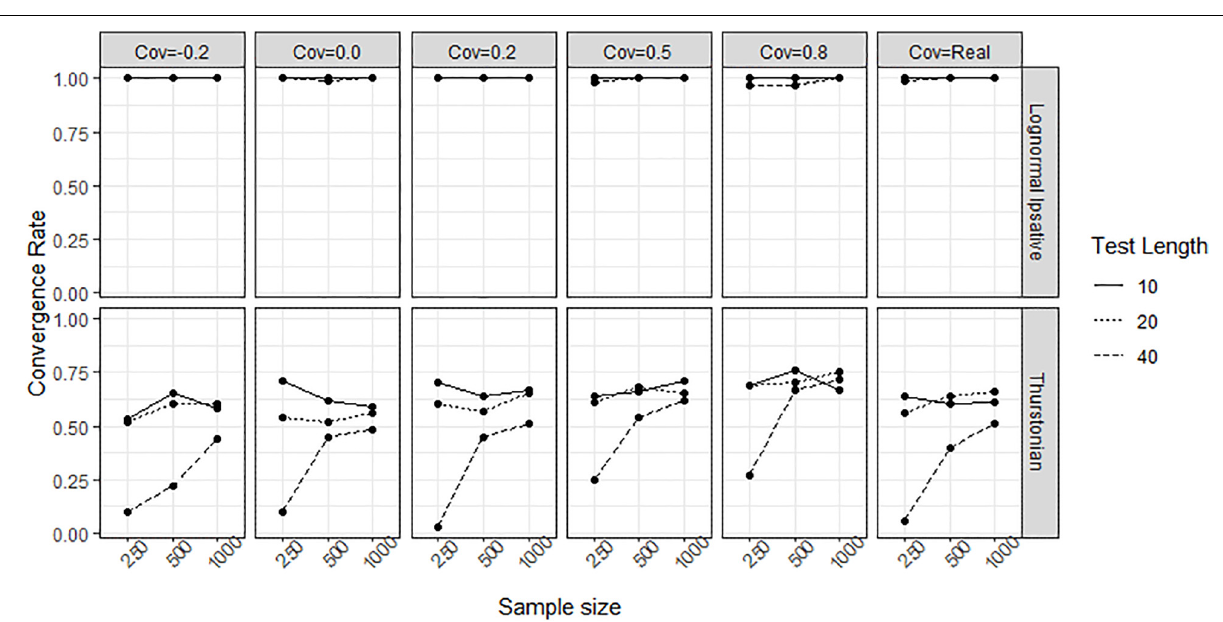
Frontiers in Psychology |